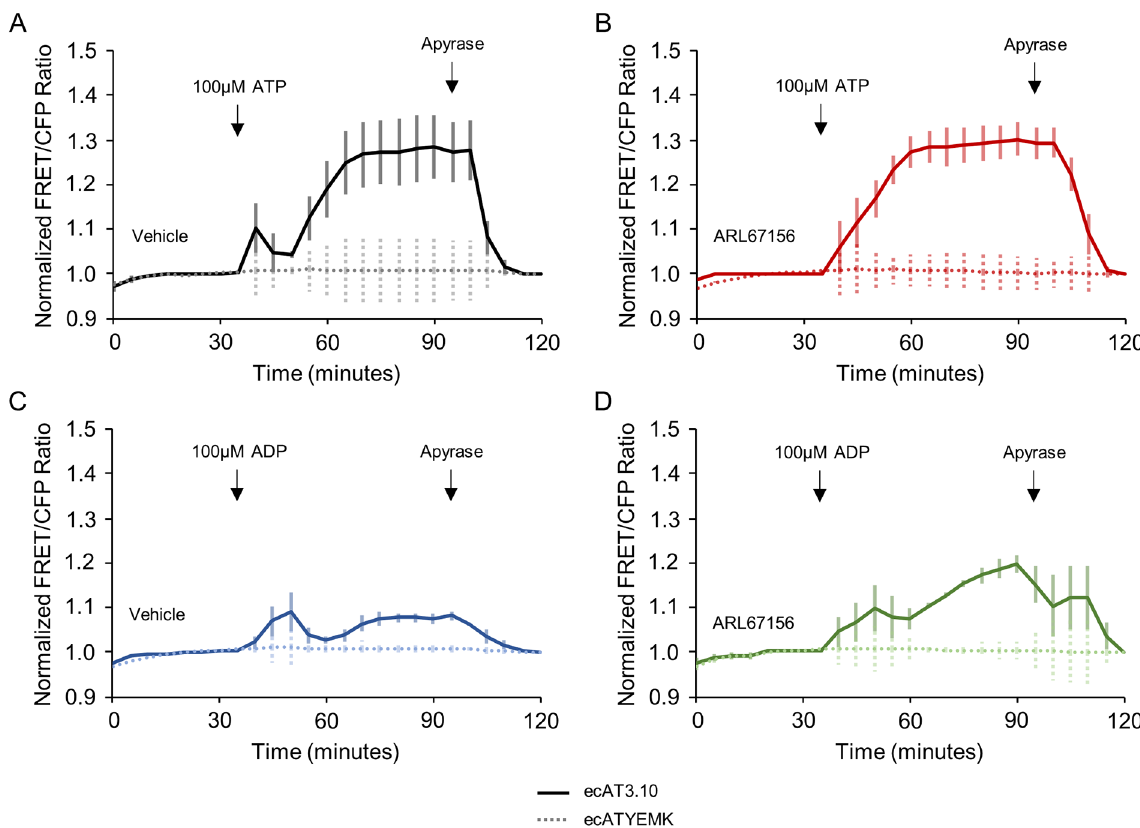
Fig 5. ecAT3.10detects nucleotide-stimulated releaseof ATP from cells. (A) A biphasicresponsewas apparenton average when 100 μ M ATP was added at time = 30 minutes to the static bath of ecAT3.10-expressing Neuro2Acells. The decreasein signal at time = 45 minutes is due to ARL67156-sensitiveectonucleotidase activity, and the subsequent increase in signal after time = 55 minutes reports a secondaryrelease of endogenous ATP from cells. (B) Pretreatment with 100 μ M ARL67156abrogates the transient decreasein ectonucleotidase activity. (C) Additionof 100 μ M ADP also stimulate a release of ATP from cells, which was potentiated by pretreatment with ARL67156 (D). Apyrase addition degradesextracellular ATP confirminga reversibleATP-specific sensor response. Solid lines show averageresponses from ecAT3.10, and dashedtraces show averageresponses from the negativecontrol ecATYEMK sensor (n = 3).